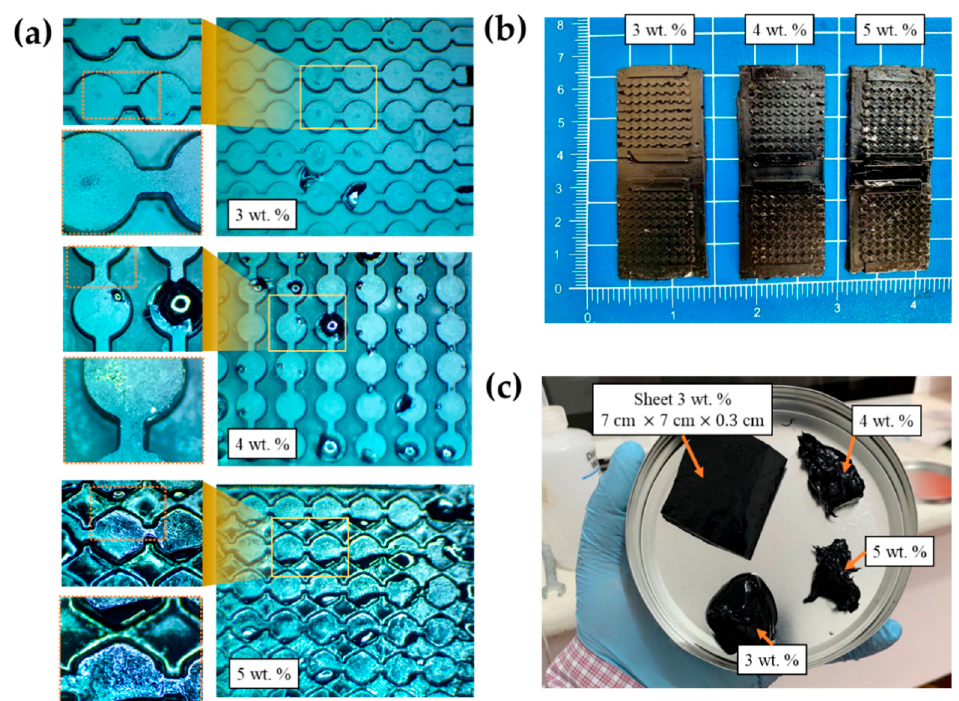
Figure 5. ( a ) Images from an optical microscope to inspect the definition of edges and defects in the patterns for different concentrations of nanotubes; ( b ) results obtained from peeling off without transverse detachment of the samples; ( c ) consistency of the viscous mixtures for different concen ‐ tration of nanotubes.